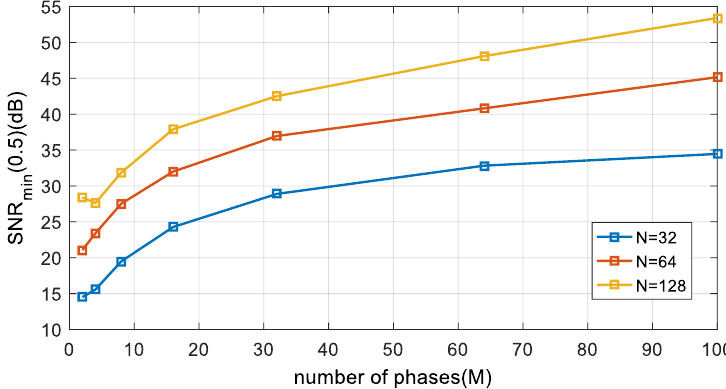
Figure 9. Improvement of the performance according to the number of phases M.